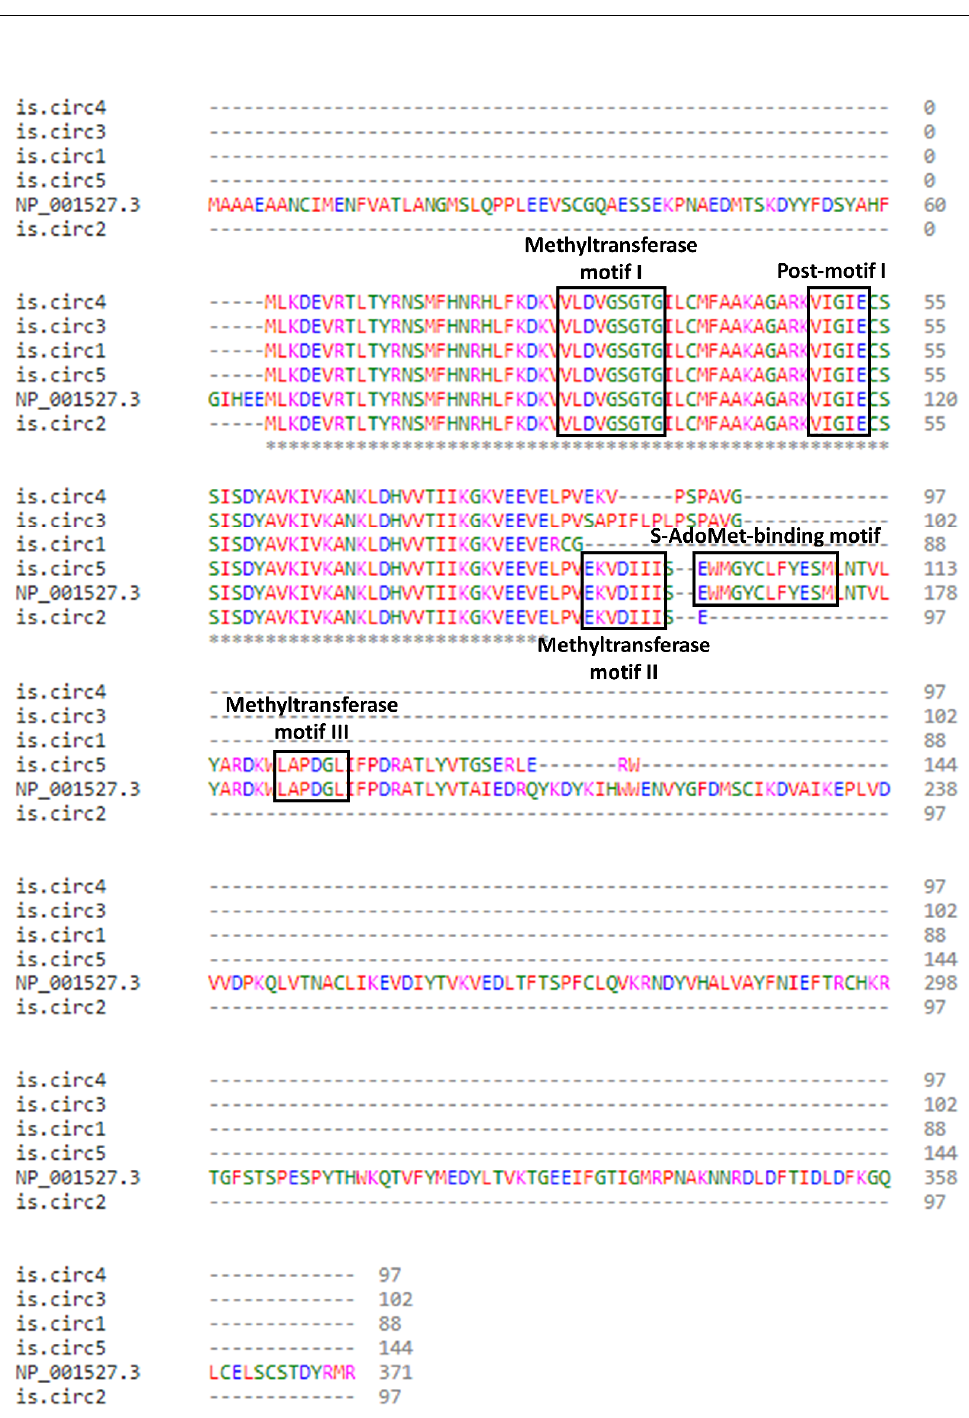
Figure 5. Clustal omega multiple sequence alignment of the amino acid sequences derived from the translation of the 5 PRMT1 circRNAs that possess an open reading frame, including the sequence of the main PRMT1 isoform (NP_001527.3). All PRMT1 isoforms are predicted to possess the signature methyltransferase motif I and Post-I, while two of them possess the methyltransferase motif II, and PRMT1 is.circ5 additionally possess the methyltransferase motif III and the S-adenosylmethionine (AdoMet)-binding motif (black boxes). An * (asterisk) indicates positions which have a single identical residue. The color-coding represents the physicochemical properties of residues: red = small, hy- drophobic, including aromatic minus Y; blue = acidic; magenta = basic; green = hydroxyl, sulfhydryl, amine, plus